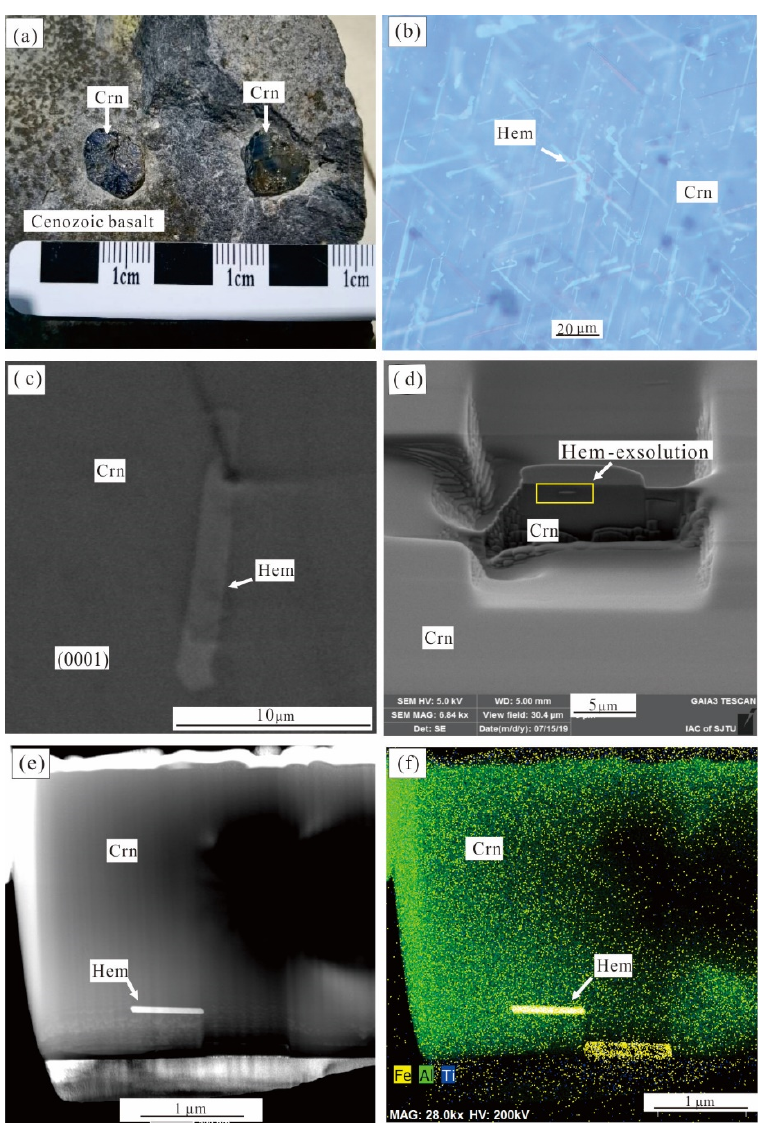
Figure 2. Optical microscope and SEM-FIB photographs of the exsolutions and the host. ( a ) Two corundum megacrysts in a Cenozoic basalt rock. ( b ) Corundum specimen under optical microscope viewed down z -axis. The exsolutions can be observed through the transparent specimen using crossed polarized light (50×). Three groups of exsolutions intersect with ~60°. ( c ) Scanning electron microscope-Back scattered electrons (SEM-BSE) photograph of the selected exsolution for FIB cut. ( d ) Scattered electrons photograph of the FIB-milled pit from lift-out perspective. A certain part for the HRTEM observation is shown in the yellow box. It is a cross-section of the middle part of the exsolution in ( b ). ( e ) High-angle annular dark field HRTEM photograph of the foil. ( f ) Microscopic element mapping photograph of the foil. Yellow represents Fe, green represents Al, respectively. The hematite exsolution is arrowed.